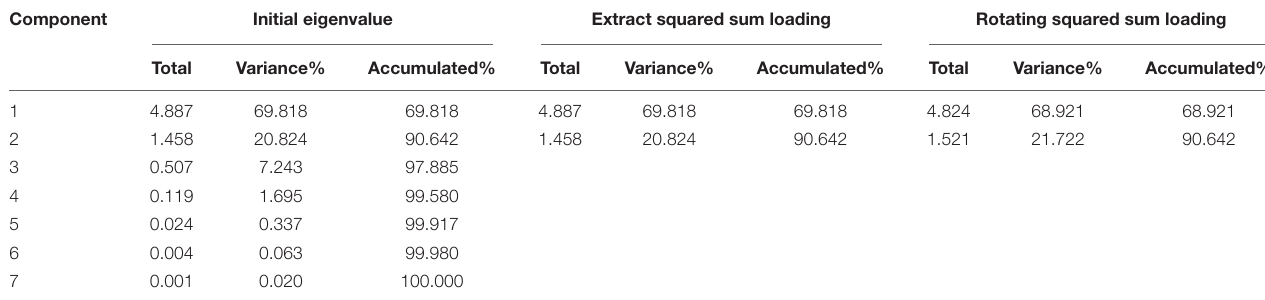
TABLE 9 | Total variance of interpretation.